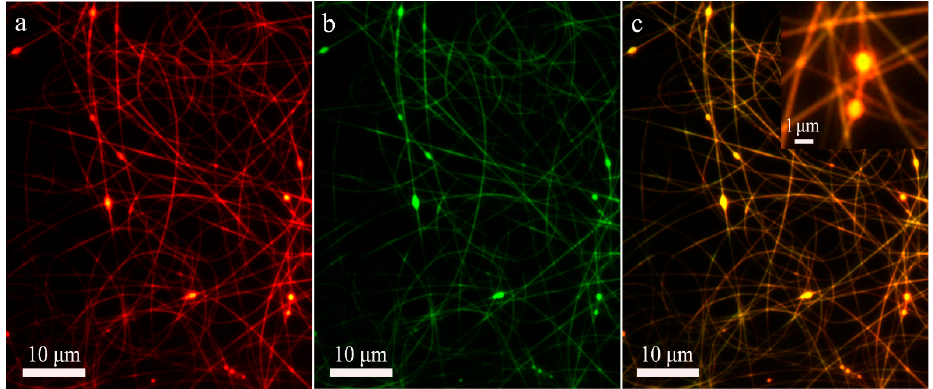
Figure 5. Fluorescence microscopy images of co-electrospun nanofibers produced under core-to-shell flow ratio of 1:4.5. ( a ) The shell layer; ( b ) The core layer; ( c ) The composite image of core and shell layers. The inset is an enlarged image of a selected area in ( c ), showing the core-shell structure of beads. The core and shell solutions were stained with fluorescein (green) and rhodamine (red), respectively. The yellow color is composited of green color and red color.